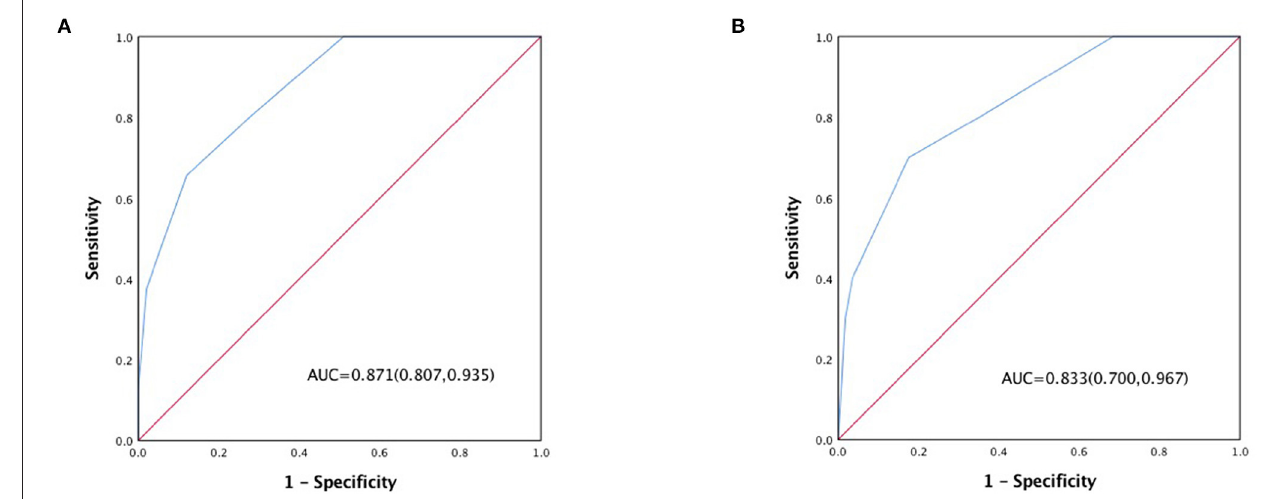
FIGURE 4 | (A) ROC curve of the 3ADPS in the derivation cohort and (B) ROC curve in the validation cohort.